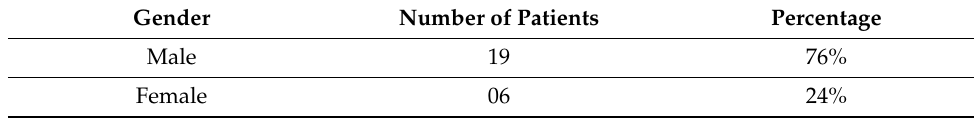
Table 2. Gender distribution of participants.